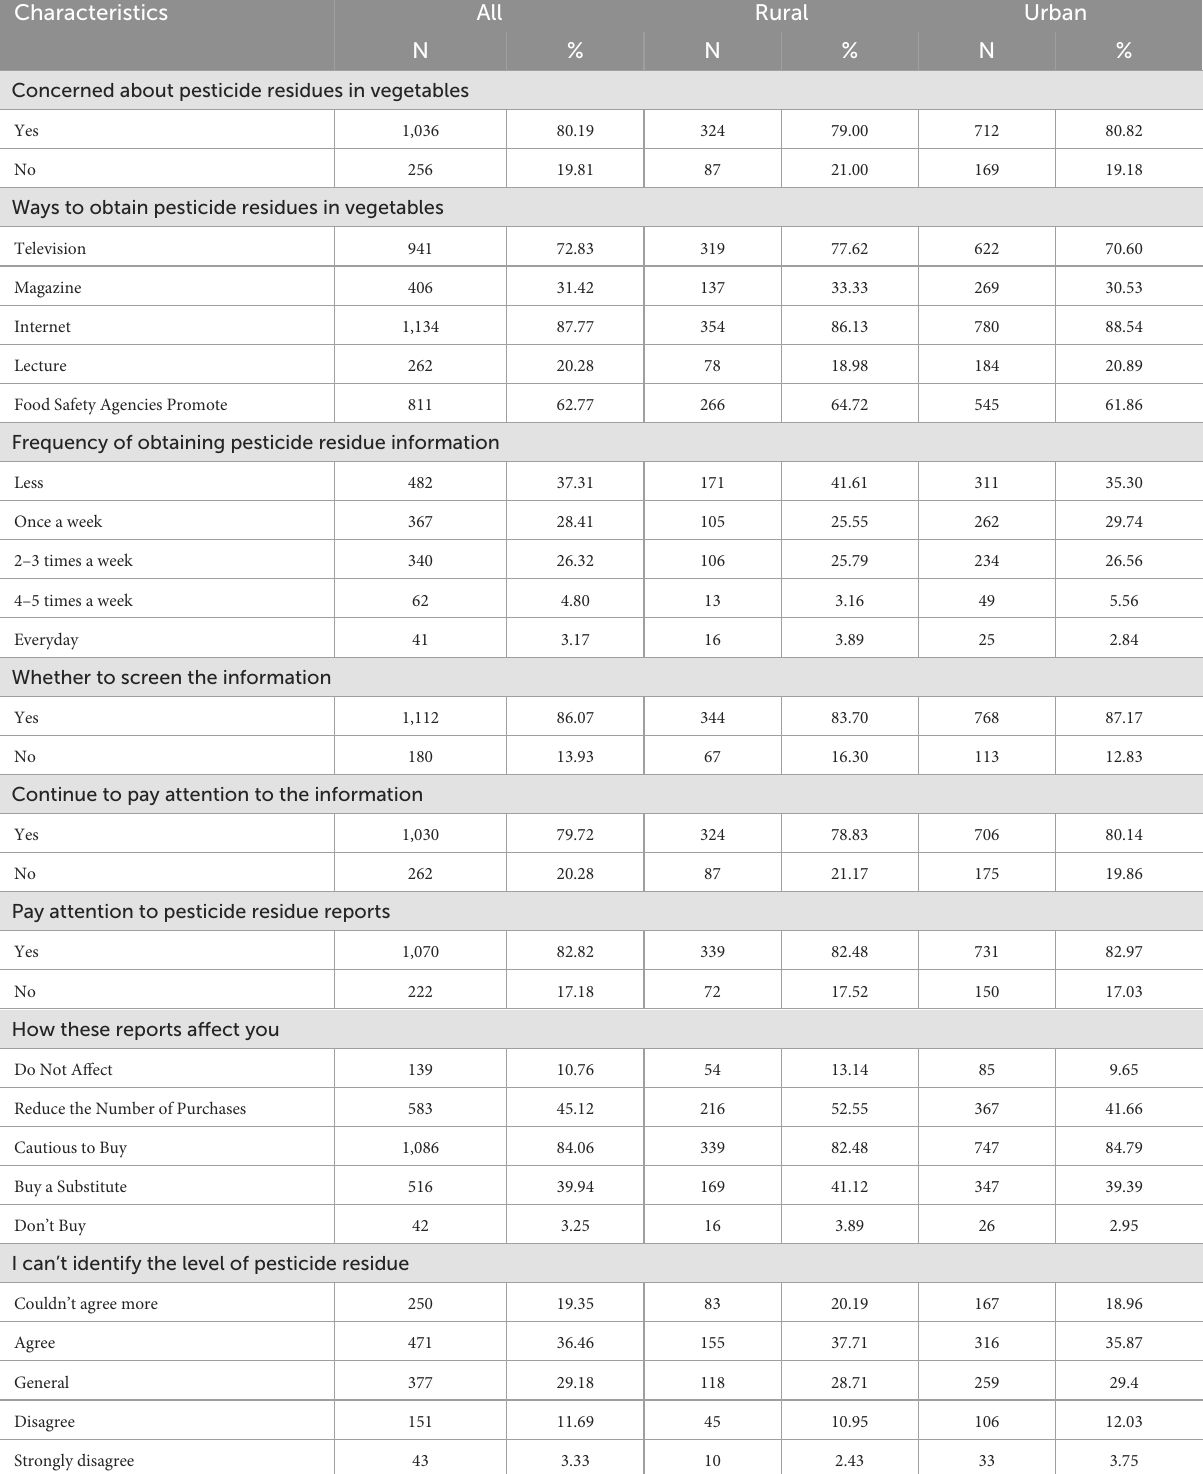
TABLE 4 Consumers’ cognition of vegetables with low residue.